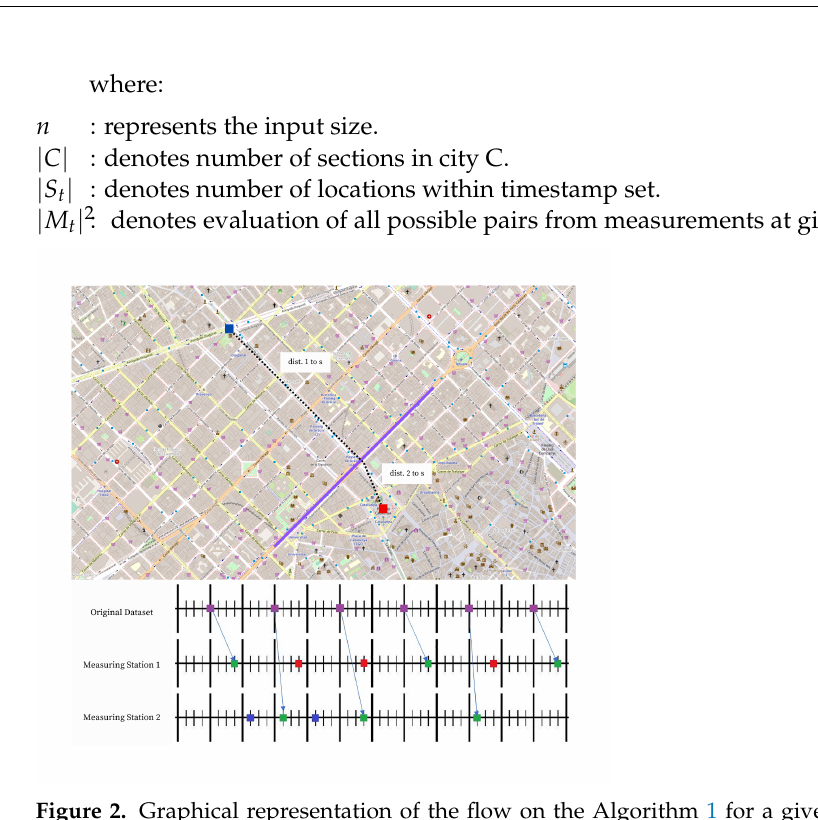
Figure 2. Graphical representation of the flow on the Algorithm 1 for a given dataset with two different measure stations and a section s